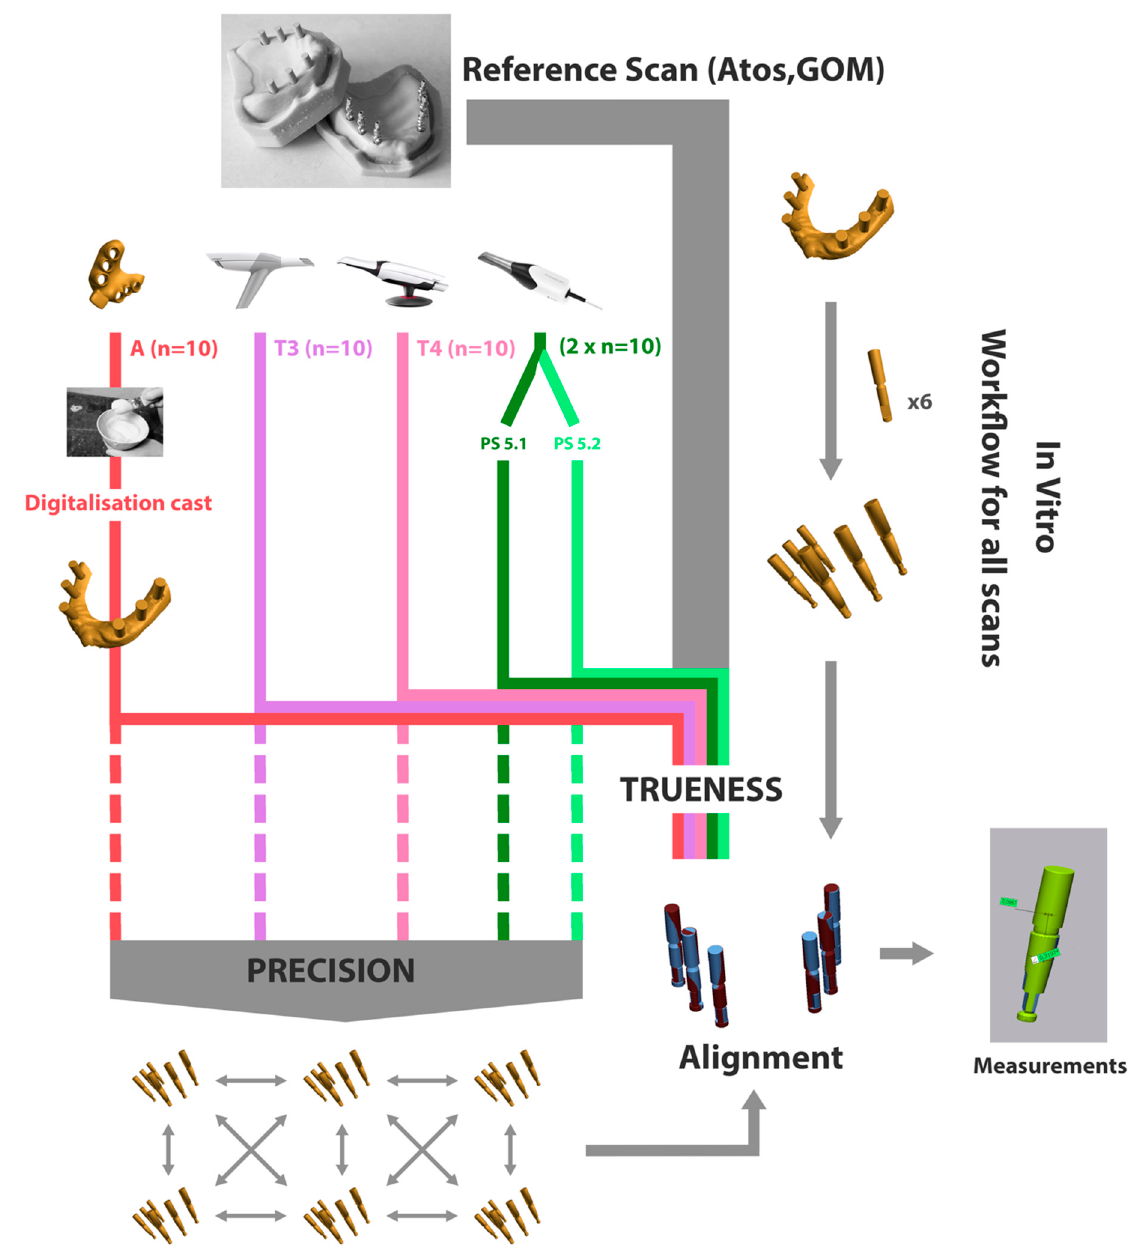
Figure 2. Workflow for trueness and precision analyses. The same workflow was followed for both models resulting in 40 digital scans and 10 conventional impressions for each model. Each of the 50 test scans was aligned with their corresponding reference scan (Atos, GOM, Braunschweig, Germany) for the trueness comparison and each group of ten testscans was aligned with each other for a precision comparison. After alignment, coronal and angular deviations were calculated for each of the six implants.